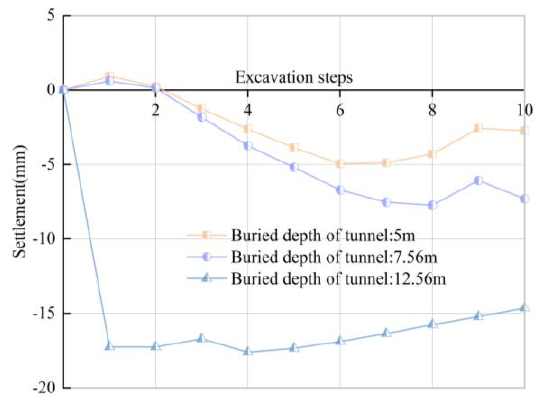
Figure 17. Influence of the buried depth of the tunnel on the longitudinal deformation of the ground surface.